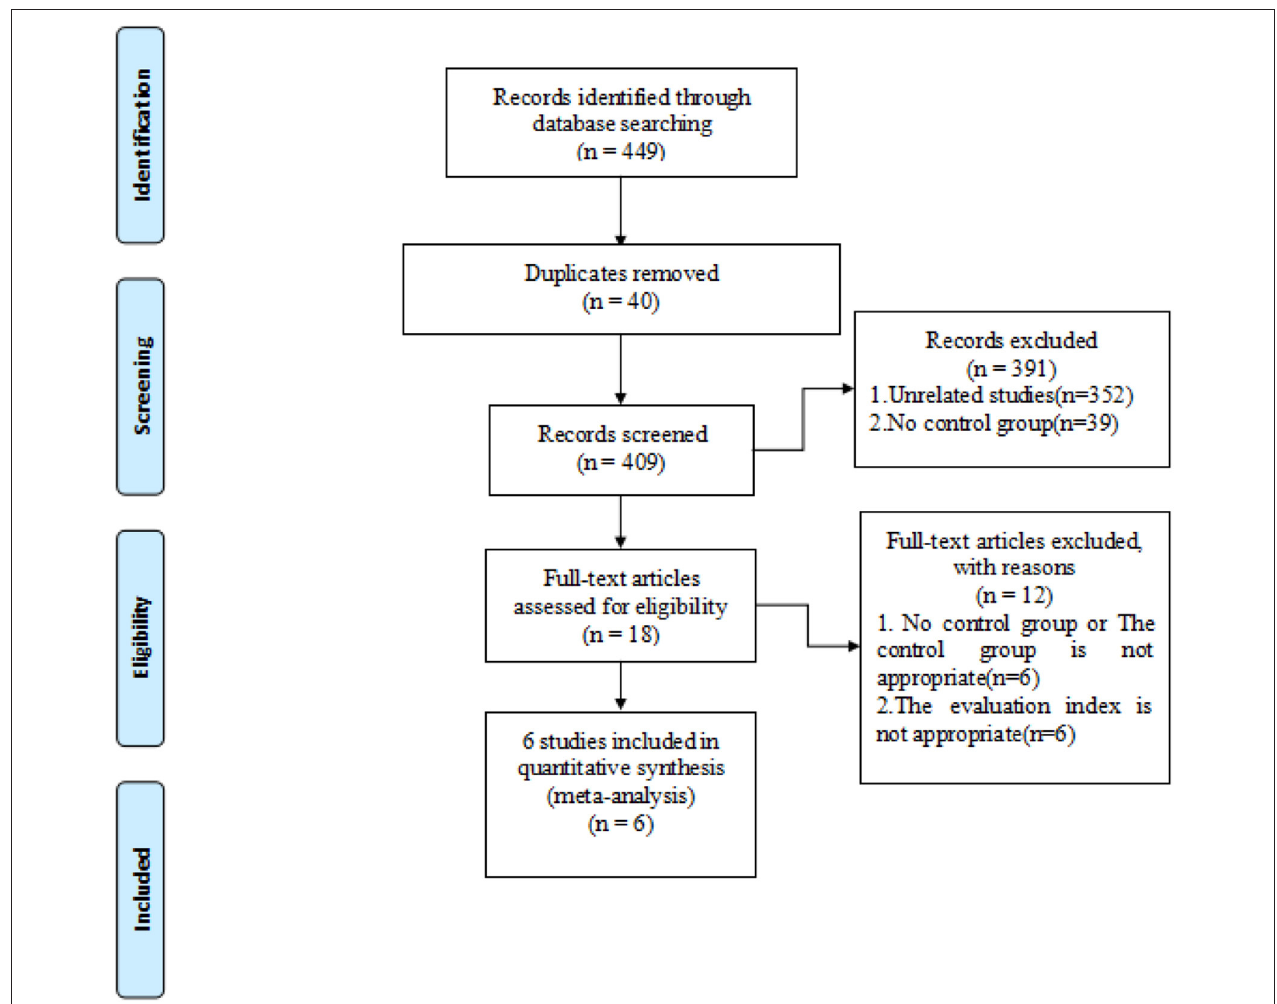
FIGURE 1 | PRISMA flow diagram of study selection